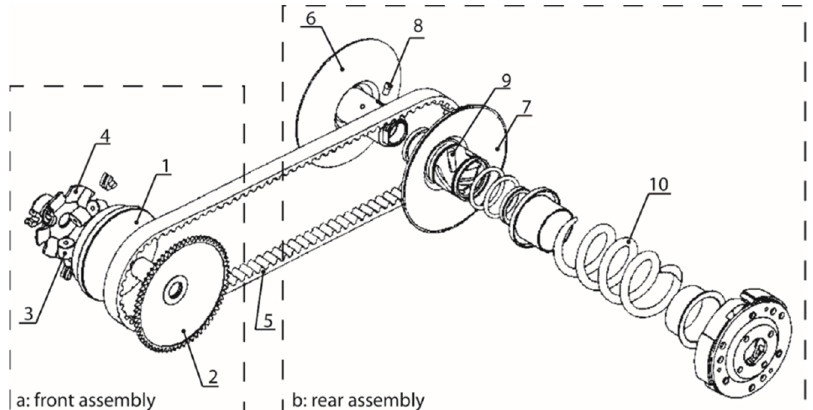
Figure 1. CVT main components.